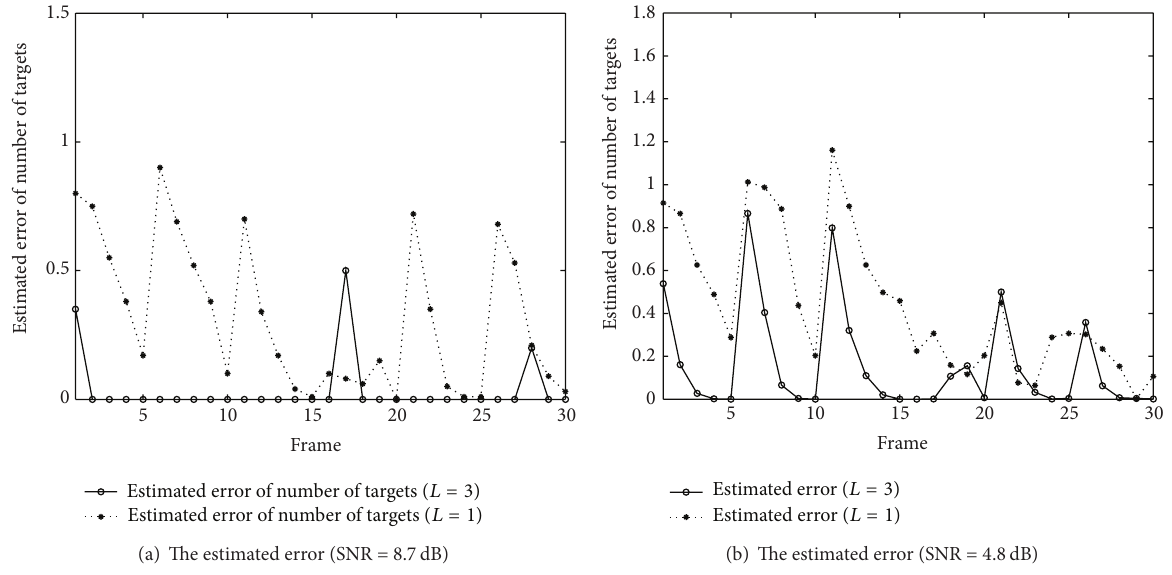
Figure 10: The estimated error of number of targets at different SNR.